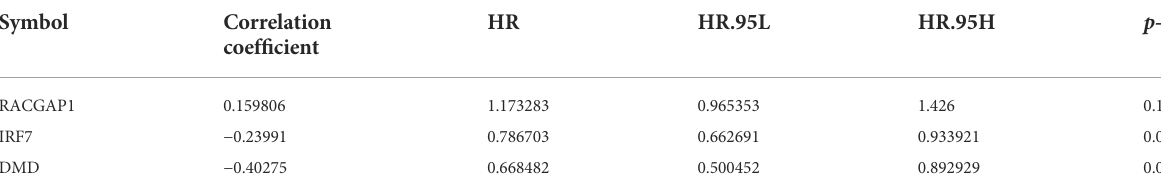
TABLE 2 Multivariate Cox proportional hazards regression analysis.